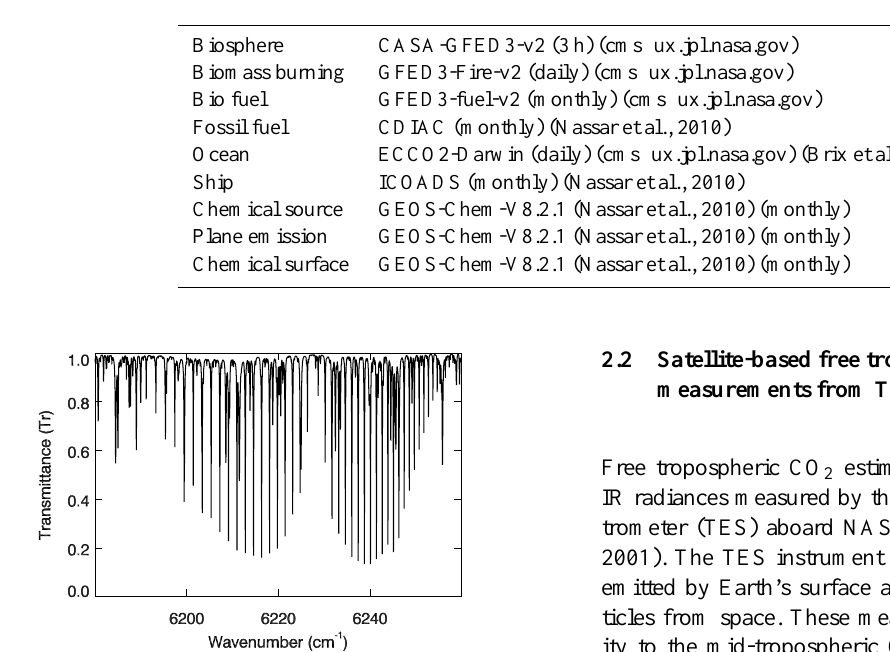
Table 1. Surface fluxes used in GEOS-Chem model.